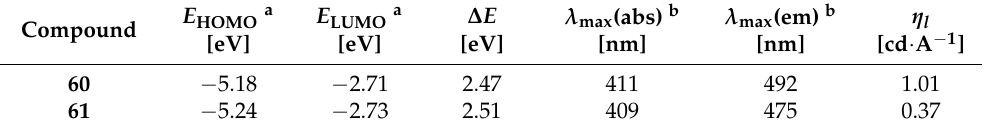
Table 2. The optoelectronic properties of polymers 60 and 61 bearing the TT scaffold.